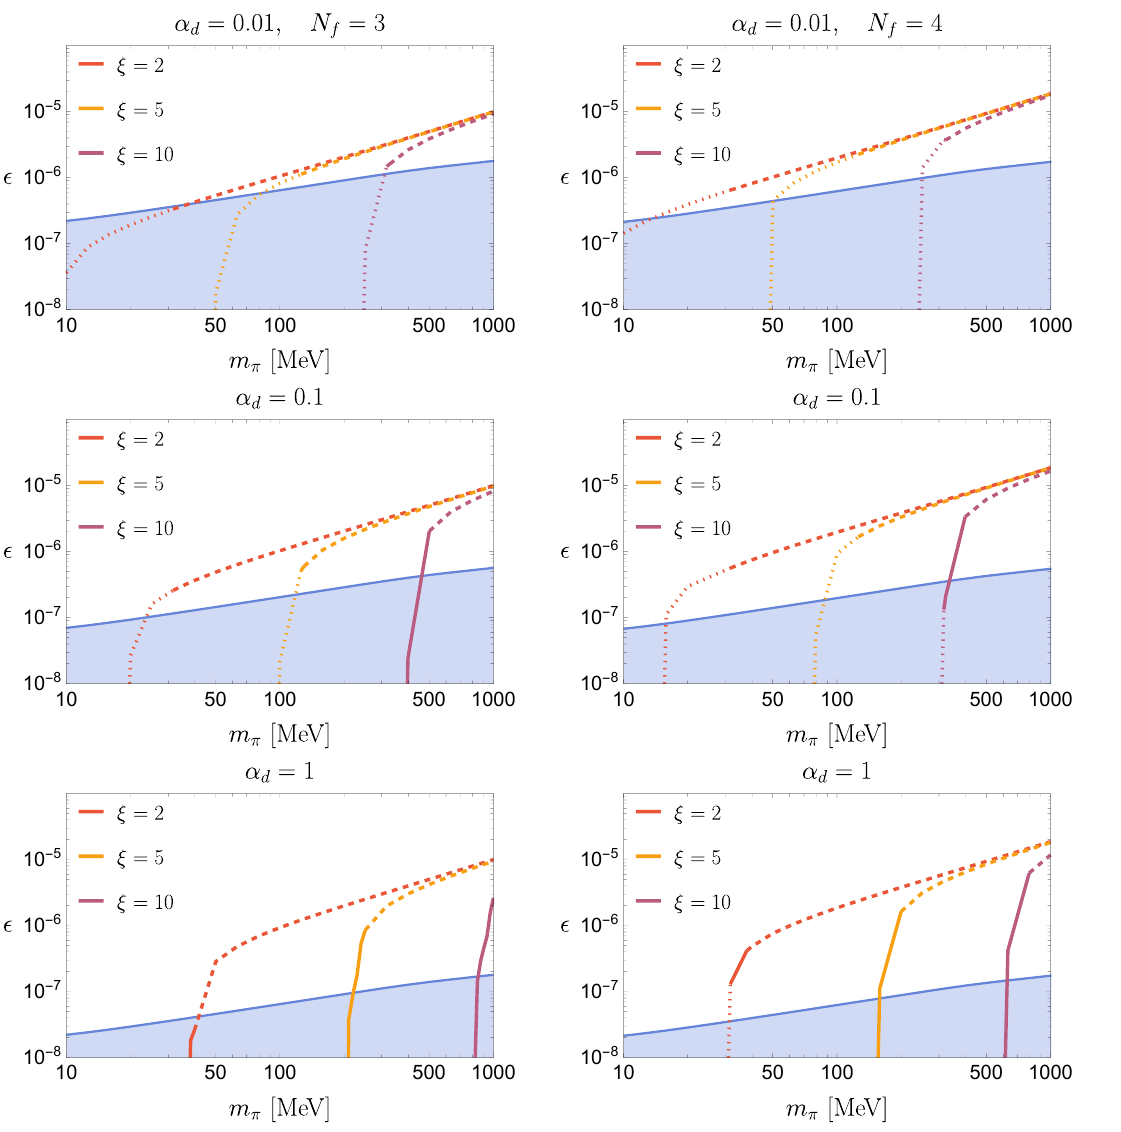
Figure 3. The values of (cid:15) for which the correct relic density is reproduced as a function of the pion mass, for different values of ξ (coloured lines) and α d for N f = 3 (left) and N f = 4 (right). The blue shaded area is excluded by the thermalisation requirement eq. (5.2). Dotted lines violate the Bullet cluster constraint on the self-interaction. The solid lines represent the part of parameter space where the 3 → 2 interactions are the dominant freeze-out interaction. The dashed lines are when 2 → 2 annihilations via the dark photon are important at